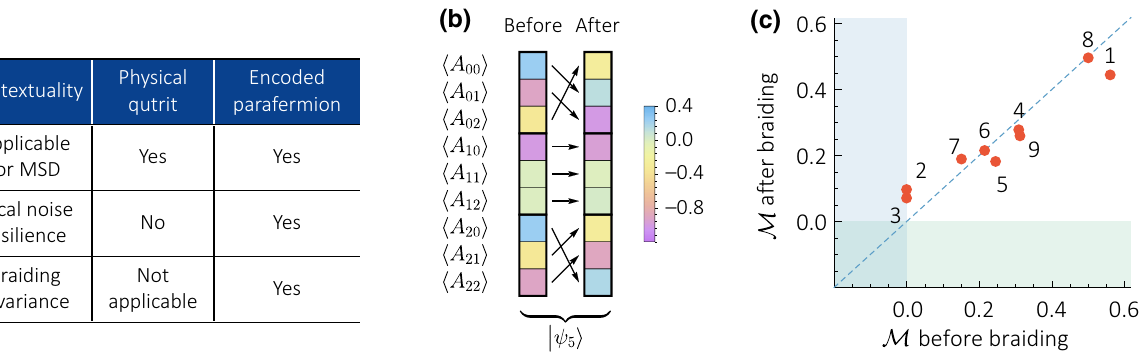
FIG. 4. The effect of braiding on contextuality. (a) A comparison of the contextuality encoded in a nontopological (physical) qutrit and a topologically protected parafermionic qutrit. A physical qutrit subject to noise may lose its ability to manifest state-dependent contextuality and support magic state distillation (MSD). On the contrary, a qutrit encoded with parafermions is inherently immune to local noise. The application of Clifford operations on the parafermion-encoded qutrit preserves its property of contextuality, which is a crucial resource for quantum computation with magic state distillation. (b) The effect of braiding on the expectation values of the contextuality witness operators A ij , i , j ∈ { 0, 1, 2 } for parafermion-edge zero-mode states | ψ 5 (cid:2) . The braiding induces a permutation between these values and thus preserves the contextuality witness M . (c) The experimental results of the contextuality witness M for the nine sample states, | ψ j (cid:2) , j = 1, . . . , 9, before and after braiding. The dashed line shows the theoretical prediction. The error bars are too small to be displayed. The result indicates that braiding of Z 3 parafermions preserves the state-dependent contextuality applicable for quantum computation with magic state distillation. The 1 σ error bars deduced from a Poissonian counting statistics are too small to be visible on the